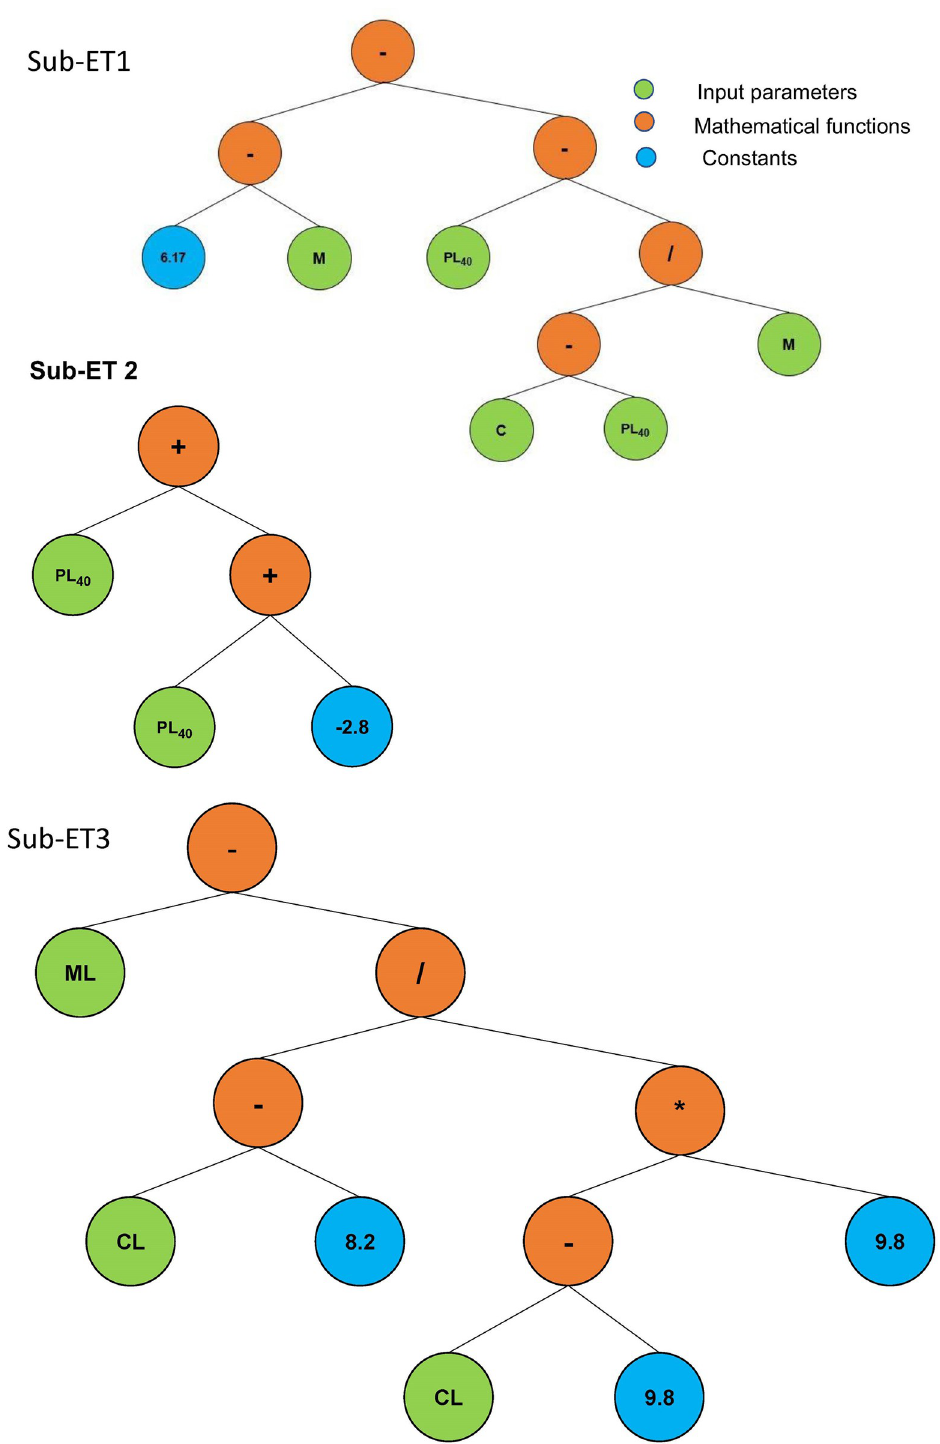
Fig 7. Expression trees [ETs] developed using gene expression programming [GEP].